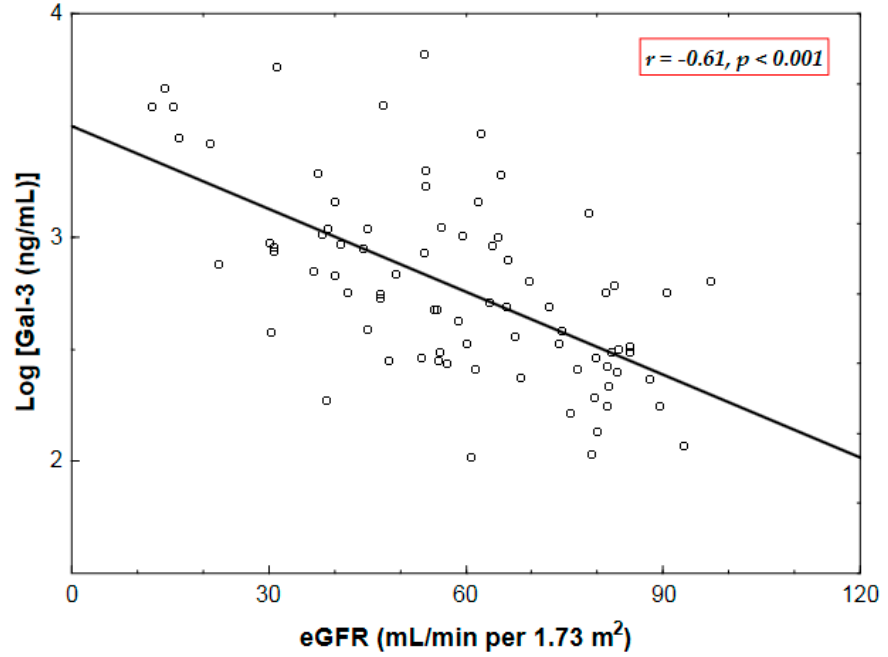
Figure 1. A negative correlation between natural logarithmically (log)-transformed plasma levels of galectin-3 (Gal-3) and estimated glomerular filtration rate (eGFR) in patients with aortic stenosis. r : Pearson’s correlation coefficient.